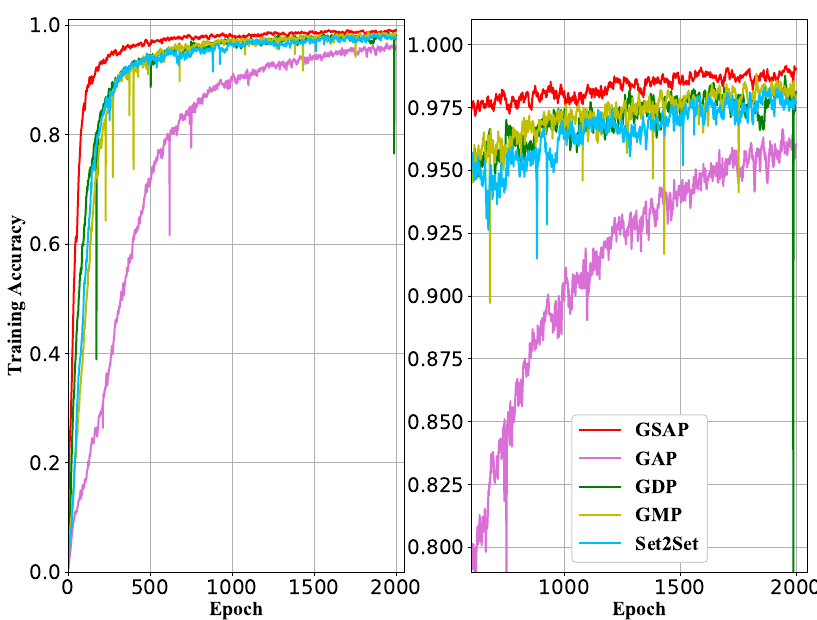
Figure 8. The Training Accuracy results. The right half is a partial enlargement of the left half. This figure reflects the expression ability of the compared global pooling methods. The higher the training accuracy they achieve, the stronger expression ability they